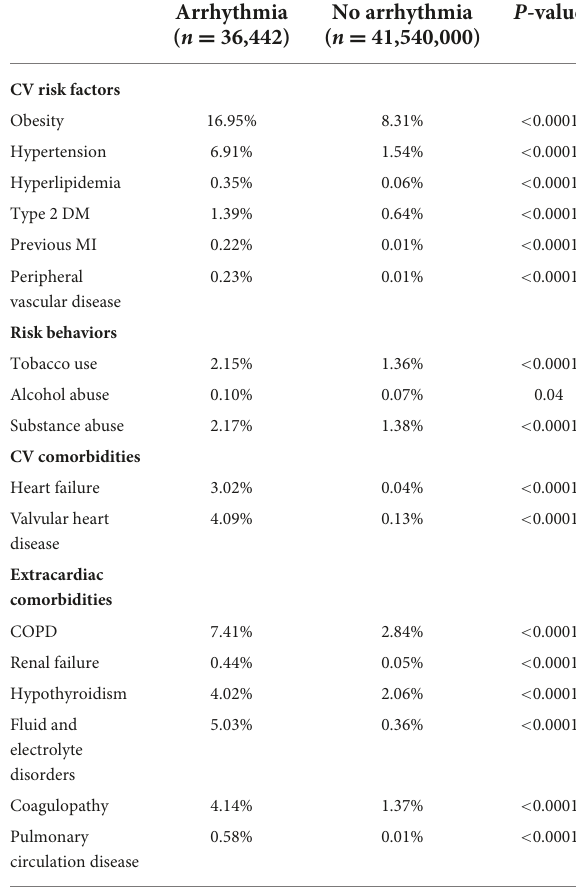
TABLE 1 Demographics and baseline characteristics of delivery hospitalizations.